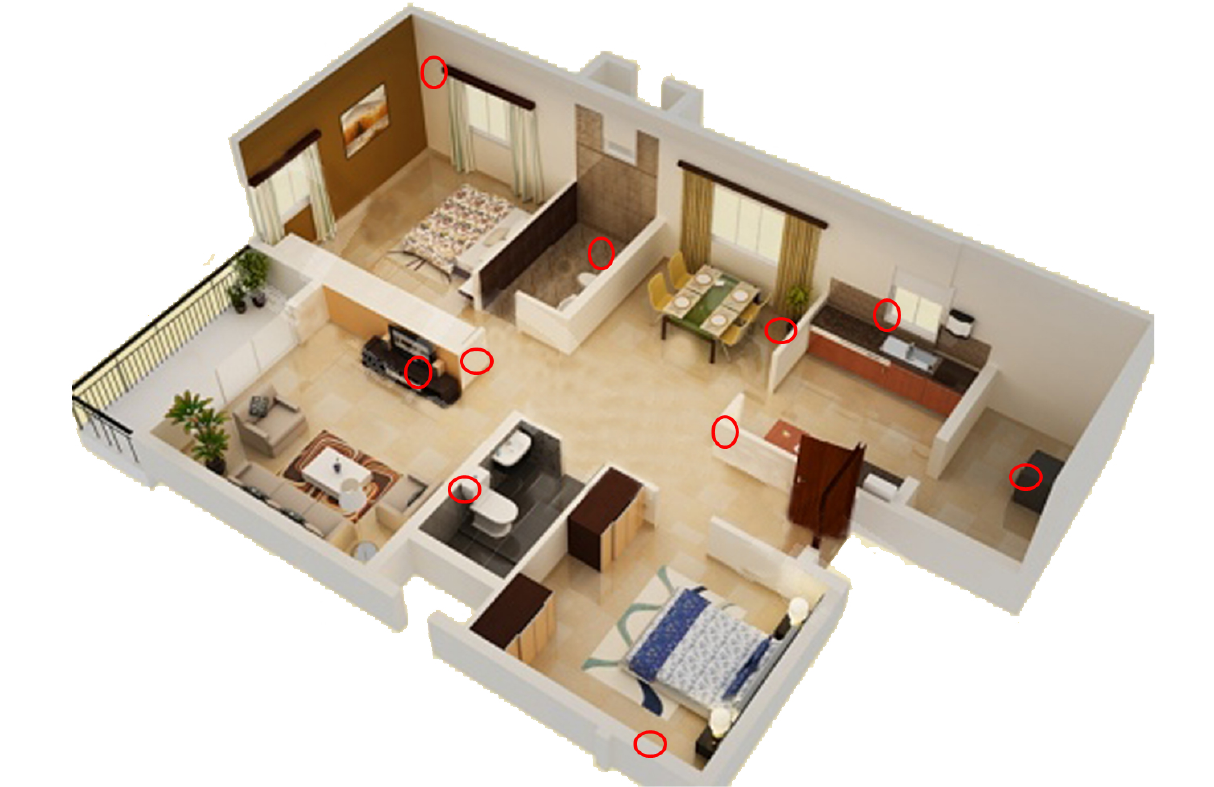
Figure 2. Example setup installed in a 2-bedroom apartment (sensor boxes indicated with red